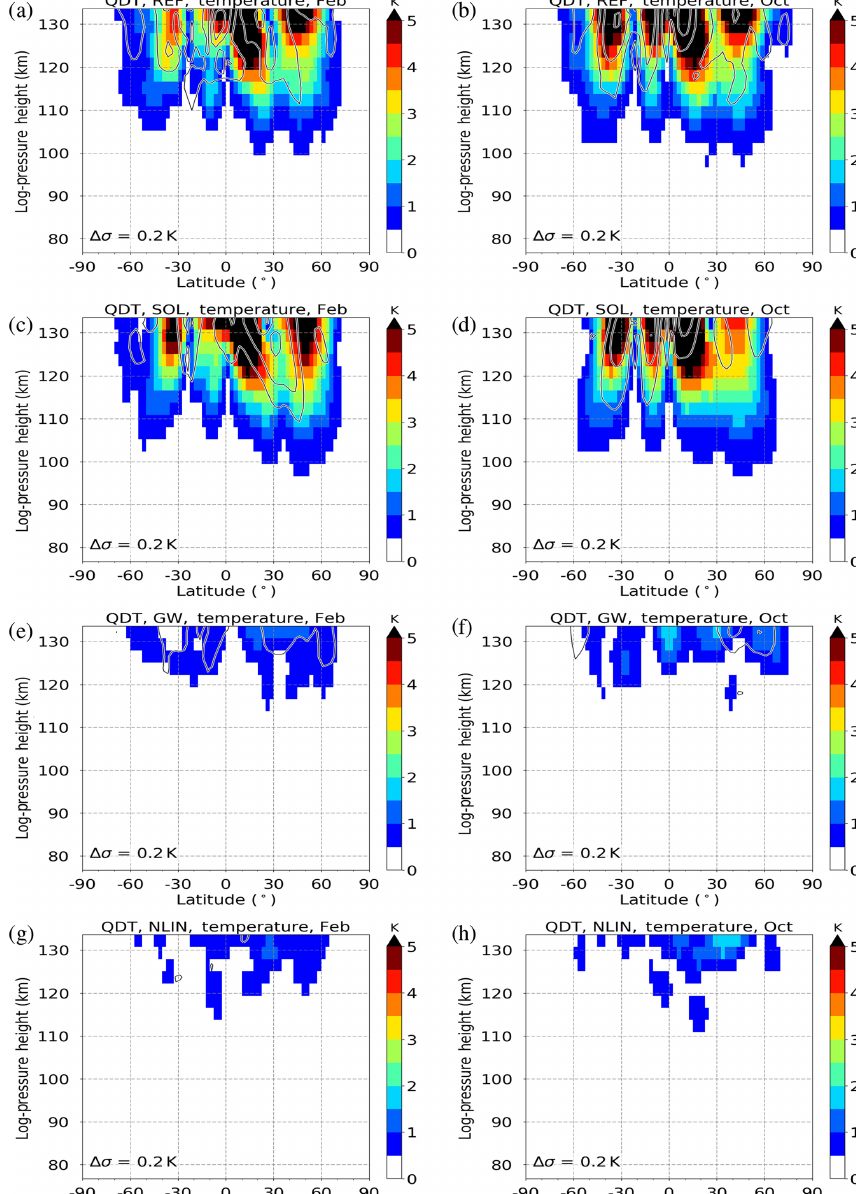
Figure 5. Simulations of zonal mean QDT amplitudes for temperature (colors), showing (a, c, e, g) February and (b, d, f, h) October conditions. Panels (a) and (b) show the REF run with all forcing mechanisms enabled, panels (c) and (d) show the SOL run with only the direct solar forcing mechanism enabled, panels (e) and (f) show the GW run with only the gravity wave forcing mechanism enabled, and panels (g) and (h) show the NLIN run with only the nonlinear forcing mechanism enabled. Standard deviations σ are added as gray contour